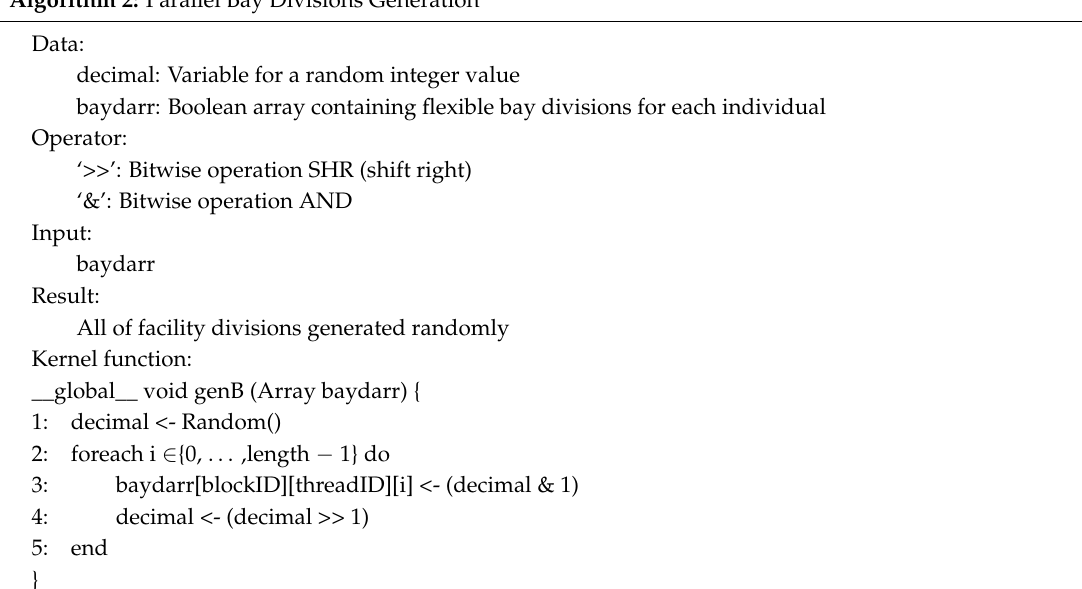
Algorithm 2: Parallel Bay Divisions